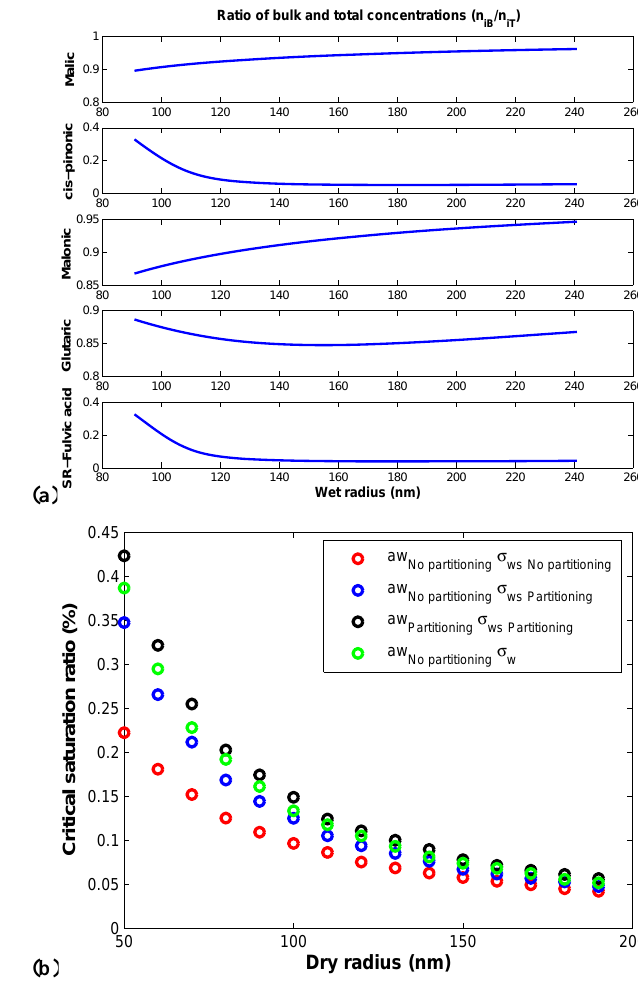
Fig. 1. (a) Surface tension isotherms. (b) Ratio of bulk concentra- tions after partitioning to those without.